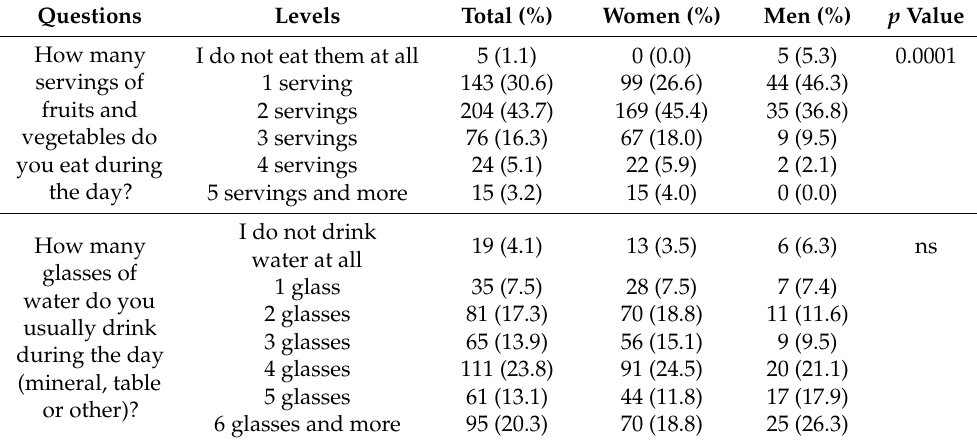
Table 5. The amount of fruit, vegetables and water consumed daily by young